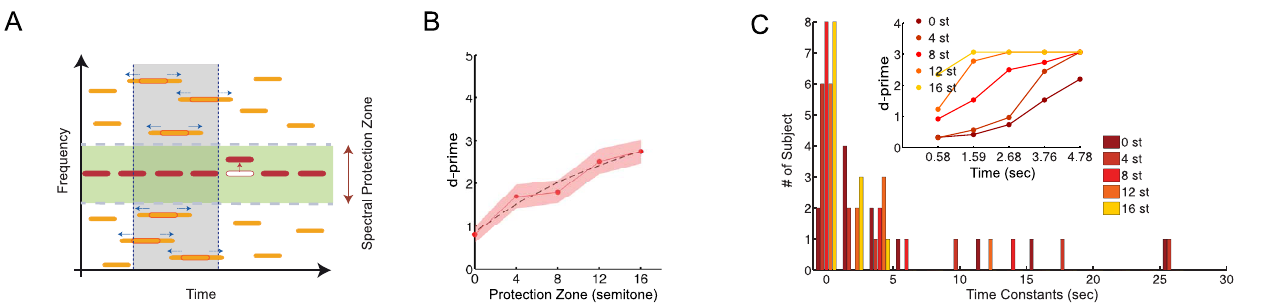
Fig. 1. Stimulus paradigm and behavioral performance. (A) Schematic representation of the stimulus design. A rhythmic sequence of pure tones (target sequence, red) is placed within a background of randomly distributed (in time and frequency) tones (maskers, yellow) and ‘protected’ by a spectral zone with no stimulus energy (green region). In the target task, subjects detected a randomly occurring frequency-shifted tone (red arrow). In the masker task, subjects were instructed to detect an elongation of all constituent tones of the masker in a 0.5 s time window (blue arrows). Each trial contained only one type of deviant, both, or none. Subjects performed the tasks in separate blocks, with the order counterbalanced across subjects. (B) Behavioral performance in the target task as a function of protection zone in a range from 0 to 16 semitones (Psychoacoustic experiment A, N 5 14) (C) Behavioral build-up of detection in the target task. Histogram of time constants obtained from exponential fitting to the buildup curves of the behavioral responses as a function of the size of the protection zone (0 to16 semitones). The inset shows behavioral buildup of target task detection for a sample subject illustrating the changes in the buildup speed as a function of different protection zone